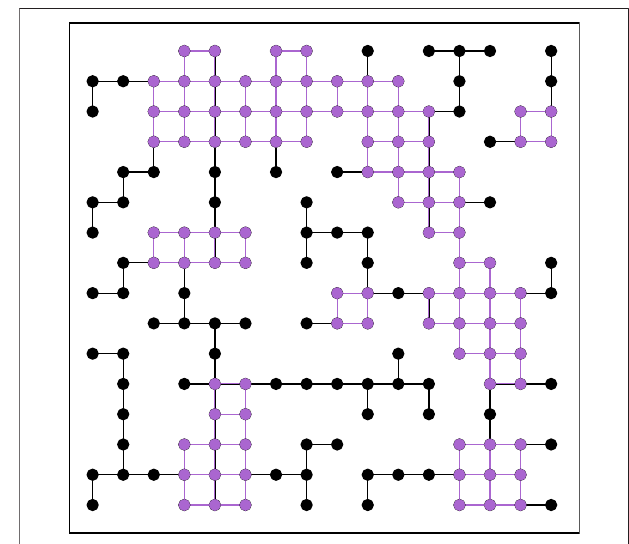
FIGURE 1 | Search of rigid clusters for a 16 × 16 square lattice system with closed boundary